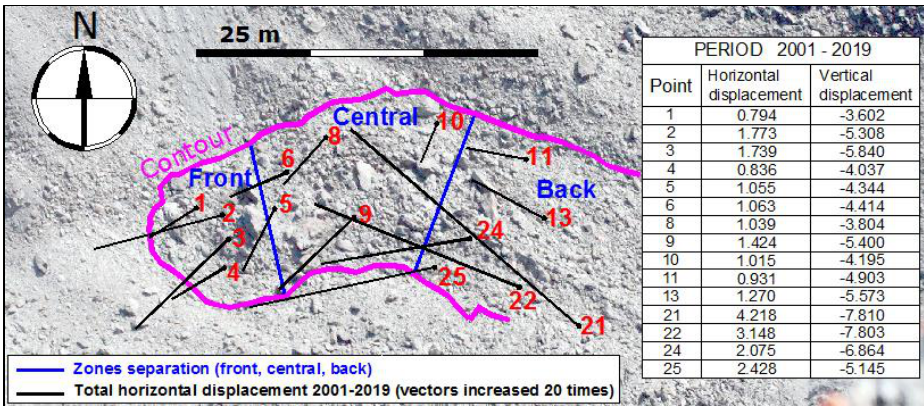
Figure 4. Displacement (horizontal and vertical) of the rock glacier (2001 – 2019). Table 1. Dynamic of steel rod 2 (located in frontal part of the rock glacier) in annual periods, and the total for the 18-year period of measurements (2001–2019). Direction Horizontal Period